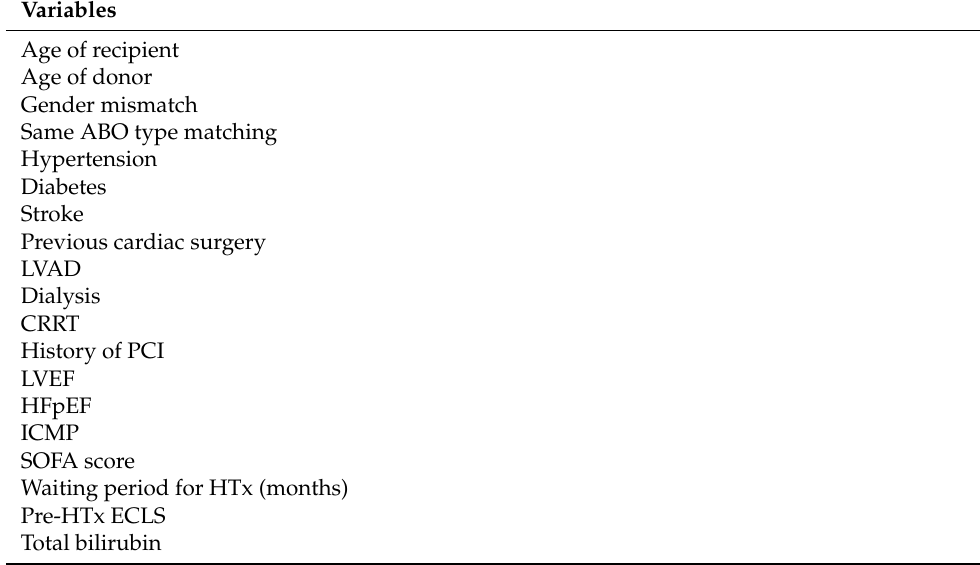
Table A2. Variables for